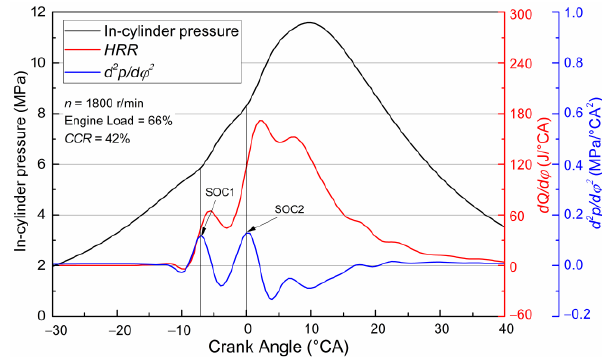
Figure 2. The determination of SOC1 and SOC2.